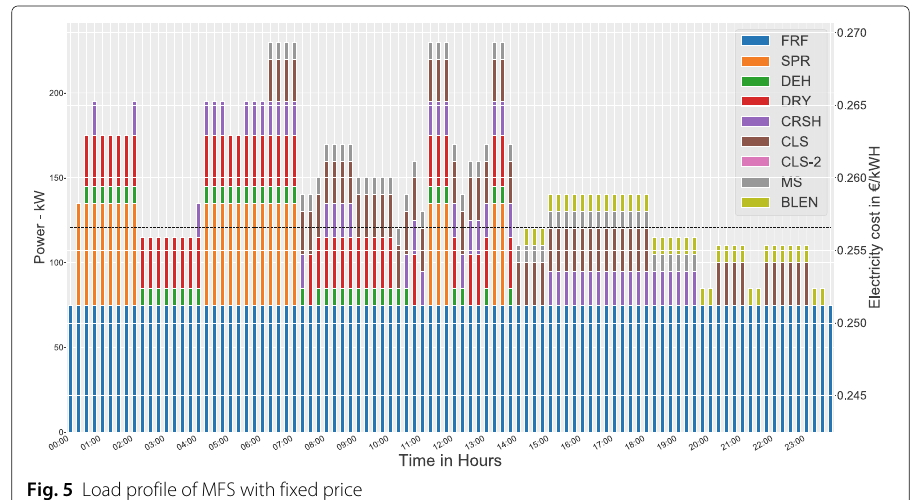
Fig. 5 Load profile of MFS with fixed